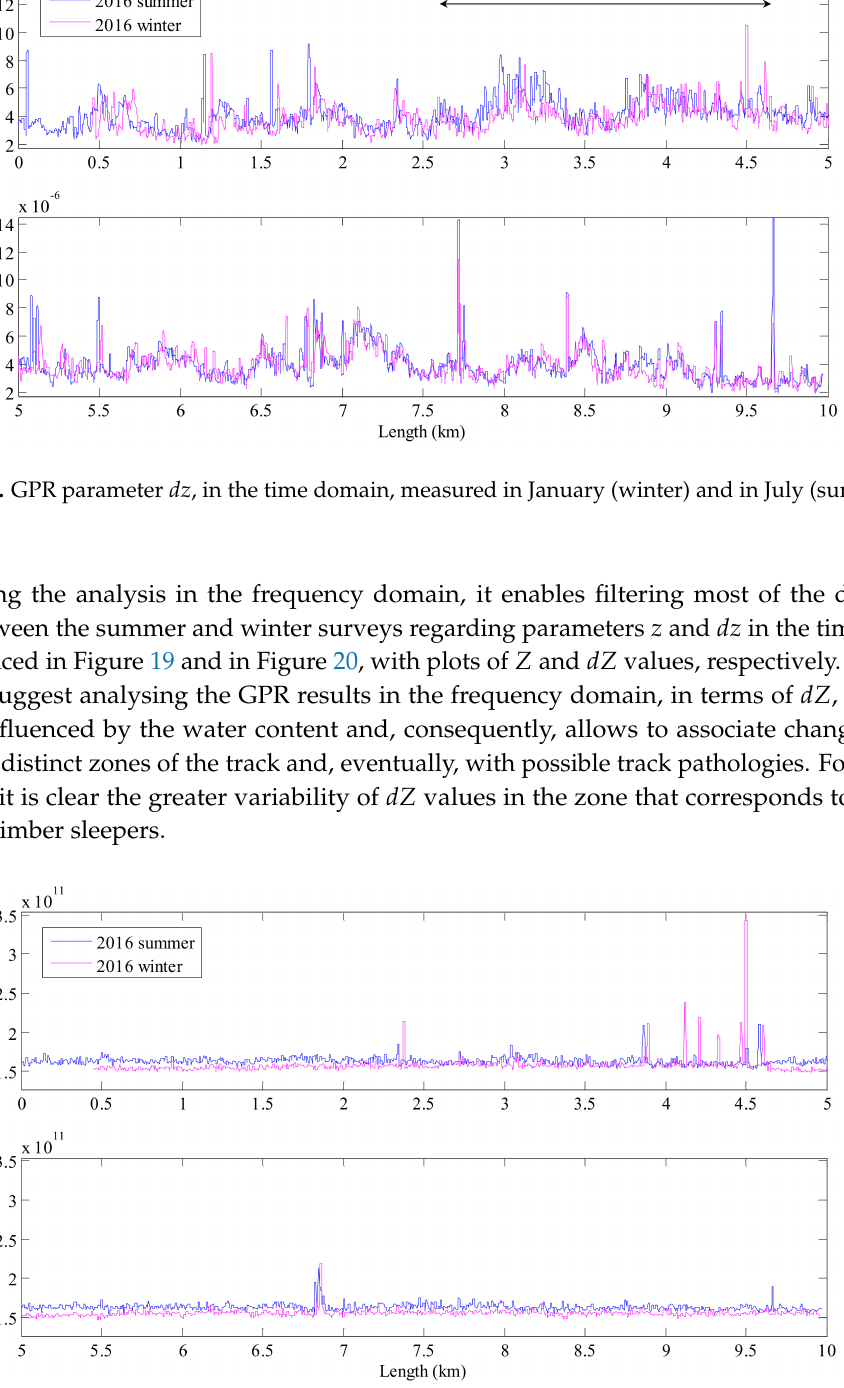
Figure 19. GPR parameter Z , in the frequency domain, measured in January (winter) and in July (summer) of